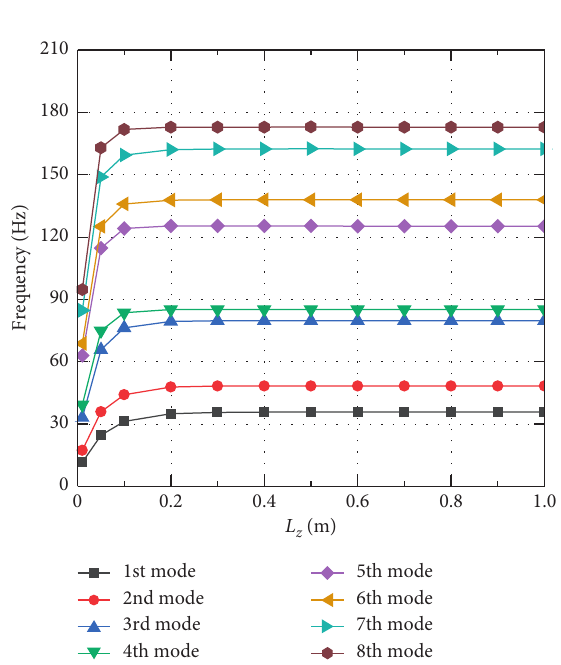
Figure 3: Variation of the first eight-order coupling frequency with various cavity